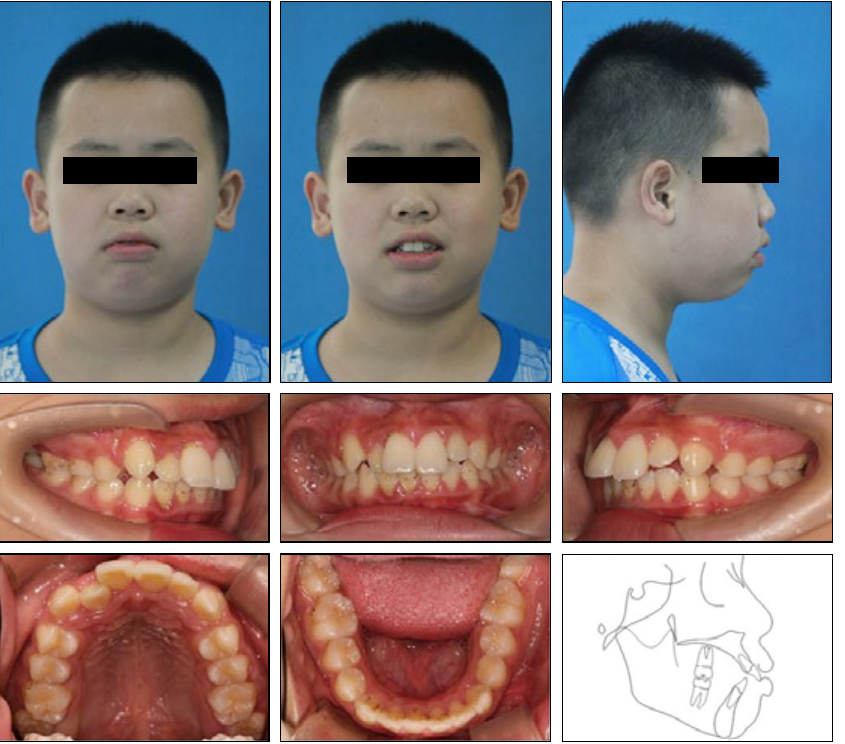
Figure 6. Phase two pretreatment photographs and cephalometric